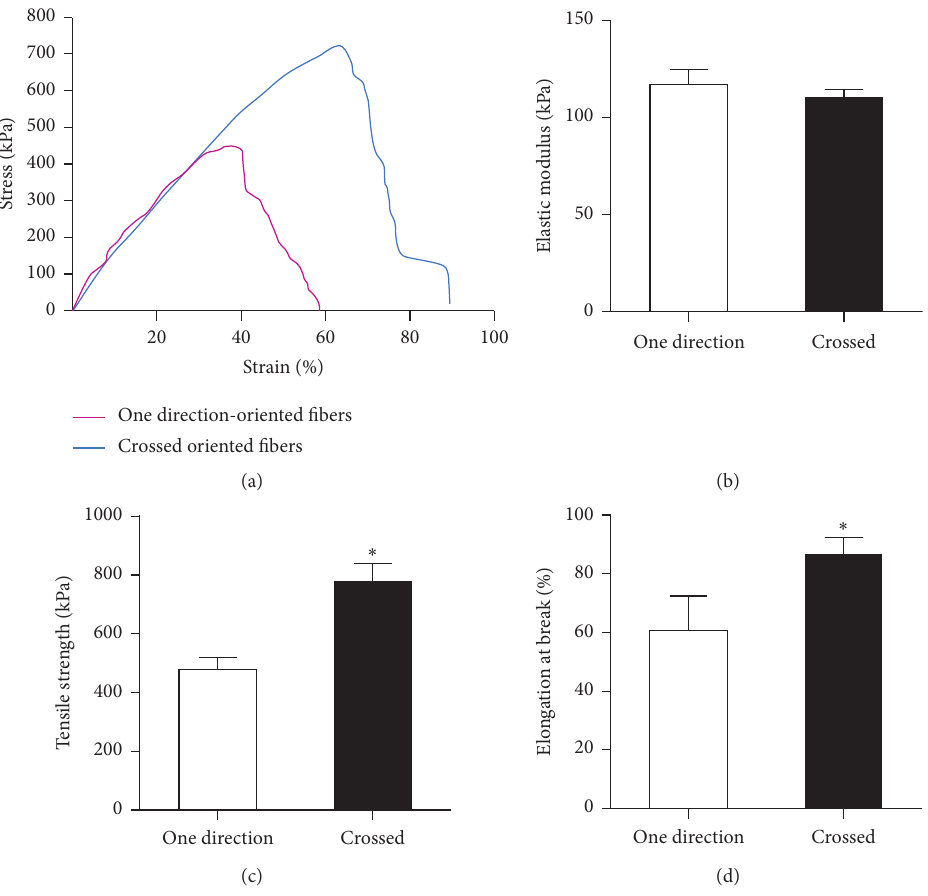
Figure 9: Mechanical properties of cross-linked electrospun collagen nanofibers were assessed for one-direction-oriented fibers and crossed oriented fibers. (a) Representative tensile stress-strain curves, (b) tensile strength at break, (c) elastic modulus, and (d) elongation at break. Data are expressed as mean ± SD ( N � 3, ∗ P < 0 .